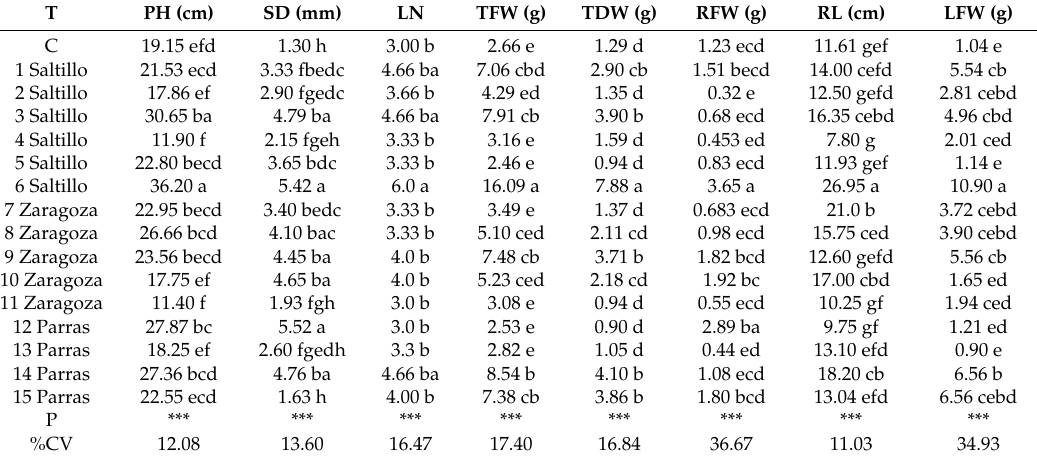
Table 8. Average effects (Tukey, p ≤ 0.05) of AMF on the agronomic parameters of greenhouse-grown onion. The letter in the table is the result of the Tukey comparison